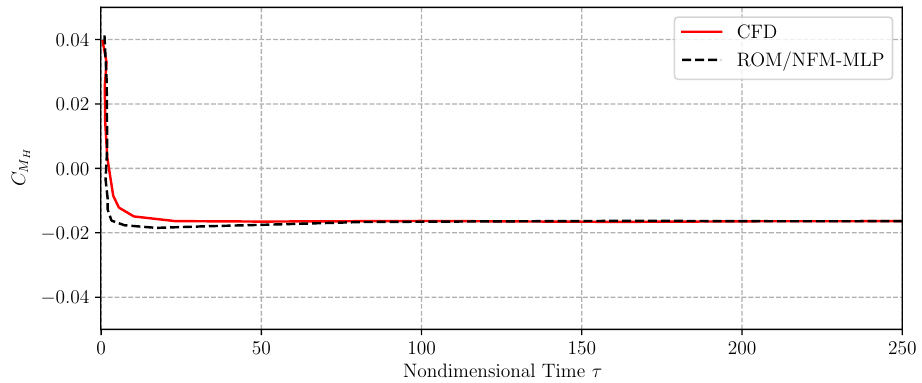
Figure 10. Stable aeroelastic response of the hinge moment coefficient (NACA65 1 213 airfoil, Ma ∞ = 0.8, Re = 10 6 , α = 0 ◦ ). The result of the NFM-MLP ROM is compared to the reference CFD solution.